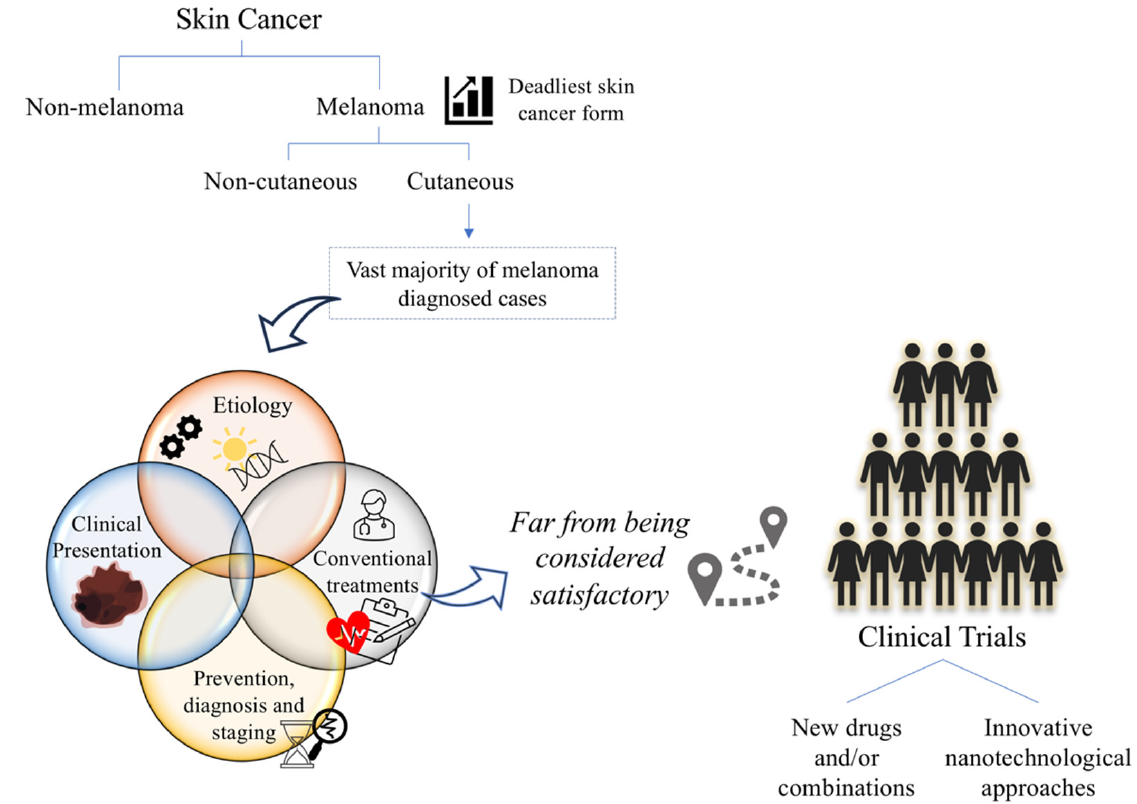
Figure 1. Melanoma: challenges and opportunities.